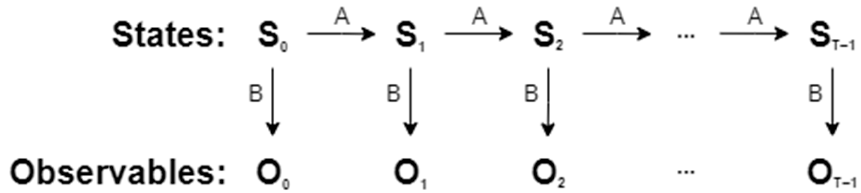
Figure 4. A generic HMM.